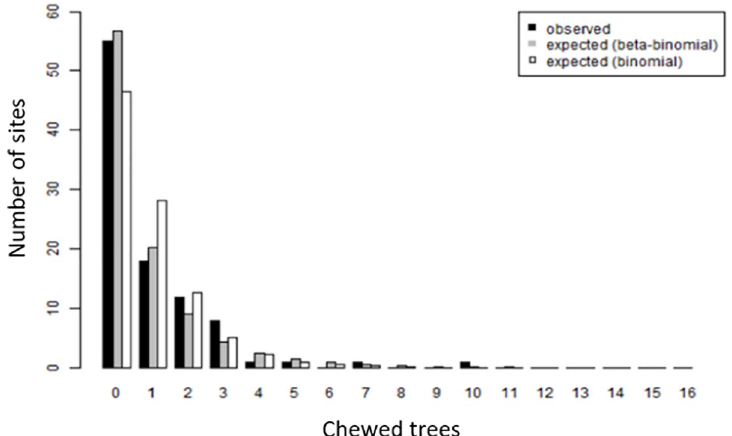
Fig 2. Observed distribution of the number of moderate or more chewed trees per site, compared to expected distribution under two models.